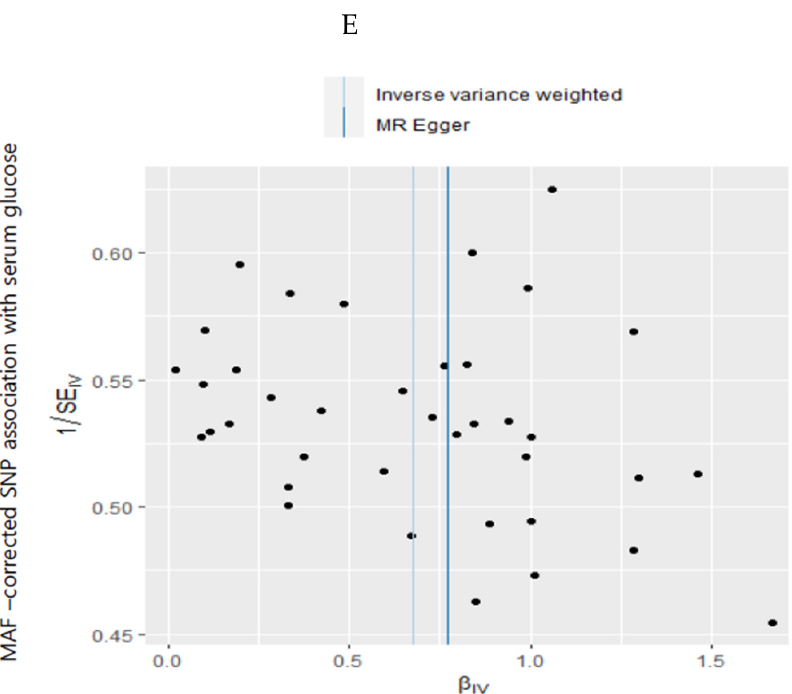
Figure 4. Mendelian randomization (MR) analysis for dietary vitamin C on the serum glucose concentrations. ( A ) Scatter plot of genetic association with the serum glucose concentrations and genetic association with the dietary VC. ( B ) Estimation of MR for the dietary VC and serum glucose concentrations risk. ( C ) Summary of the observational and genetic association of dietary VC with the risk of metabolic syndrome and its components. ( D ) Leave-one-out sensitivity analysis of MR for the dietary VC on the serum glucose concentrations. ( E ) Inverse variance weighted (IVW) and MR-Egger regression funnel plot for the dietary VC on the serum glucose concentrations. Table 3. Association of dietary vitamin C intake with metabolic syndrome and its metabolic traits using genetic variant randomization using two-sample Mendelian randomization (MR). Heterogeneity Pleiotropy